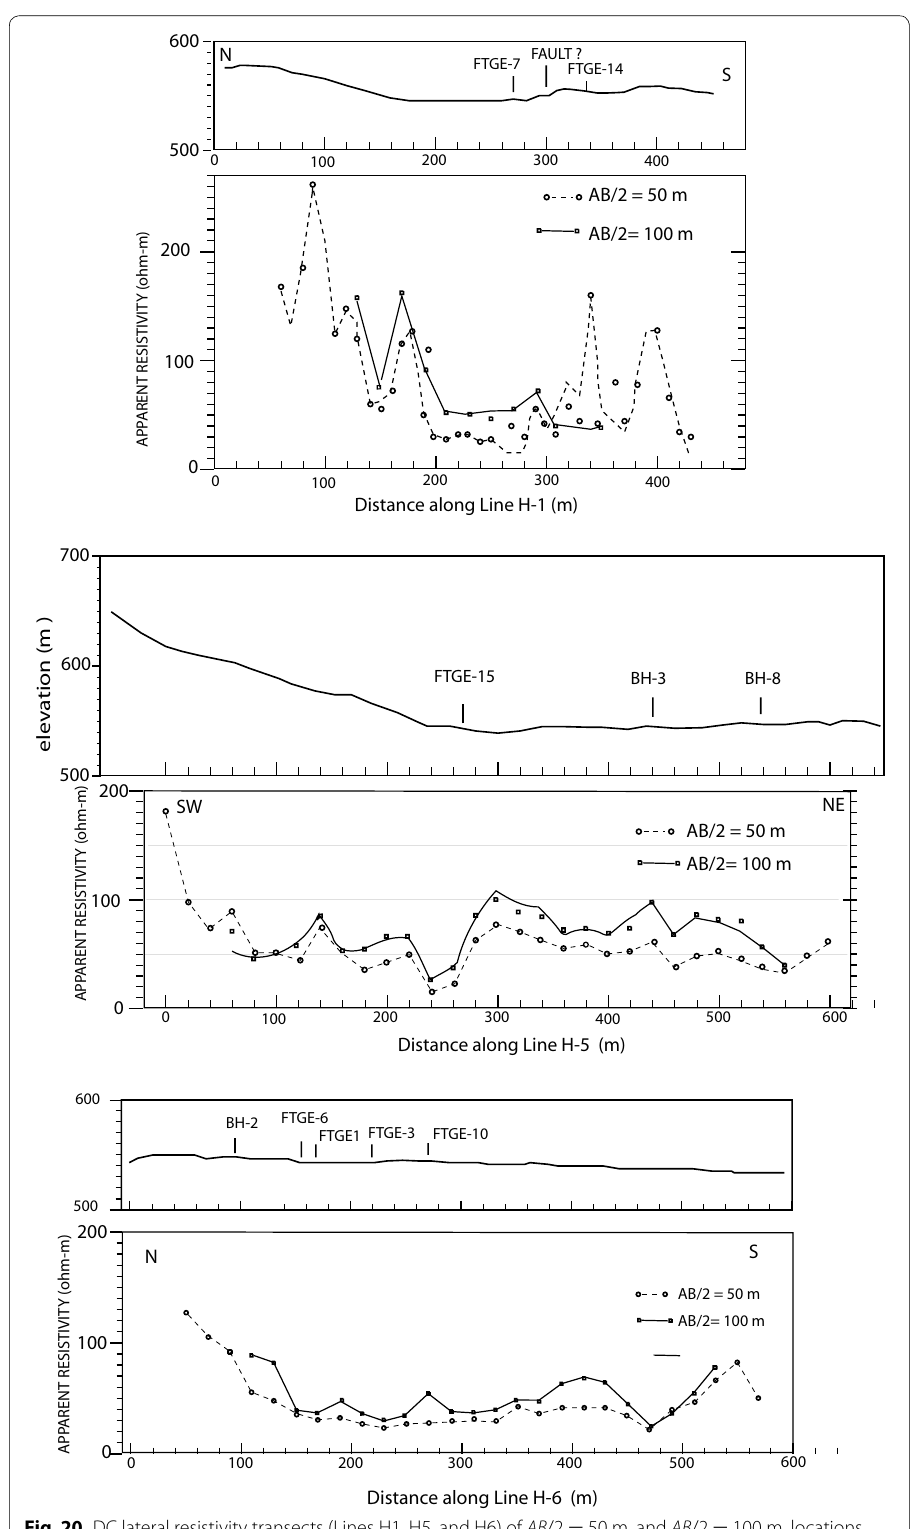
Fig. 20 DC lateral resistivity transects (Lines H1, H5, and H6) of AB /2 shown in Fig. 18 from Coothungkul and Chinapongsanond